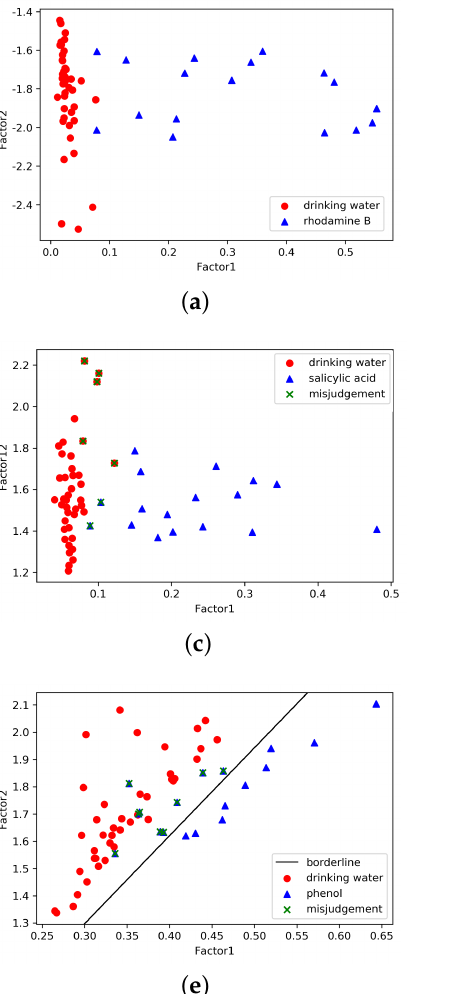
Figure 7. Identification of low-concentration testing samples using multi-way decomposition meth- ods: rhodamine B using ( a ) PARAFAC and ( b ) PCA; salicylic acid using ( c ) PARAFAC and ( d ) PCA; phenol using ( e ) PARAFAC and ( f ) PCA.